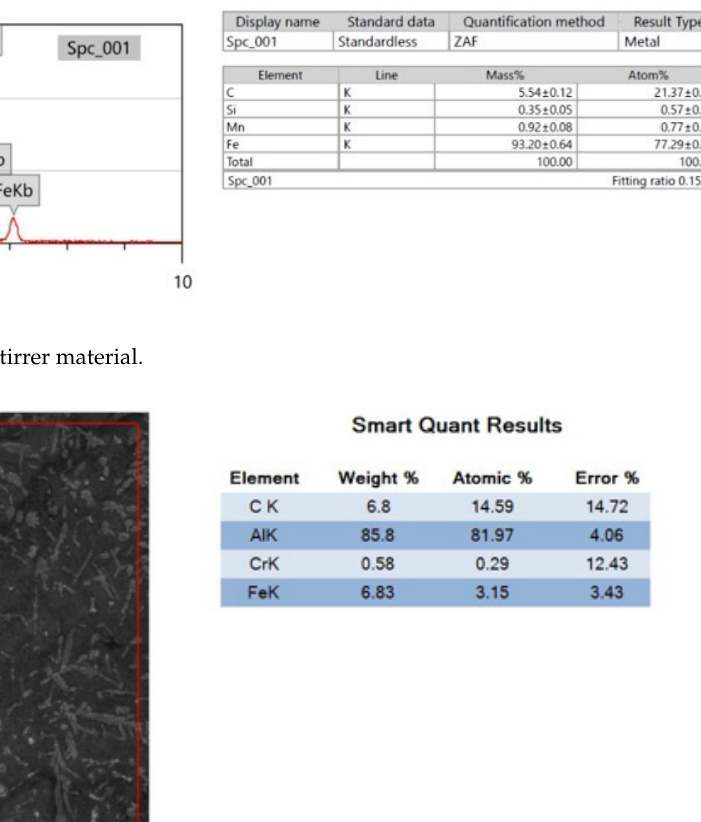
Figure 7. Theoretical and experimental densities of Al6061/TiO 2 (1wt.%), together with their porosity